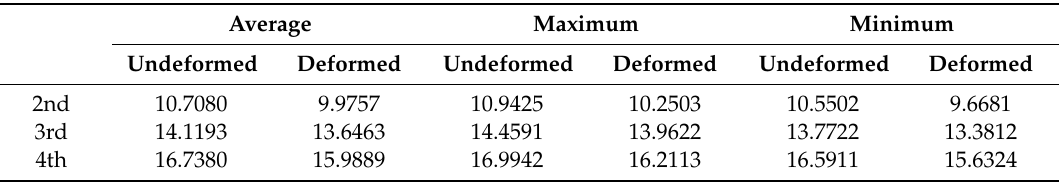
Table 2. Numerical statistics of the natural frequencies. Average Maximum Minimum Undeformed